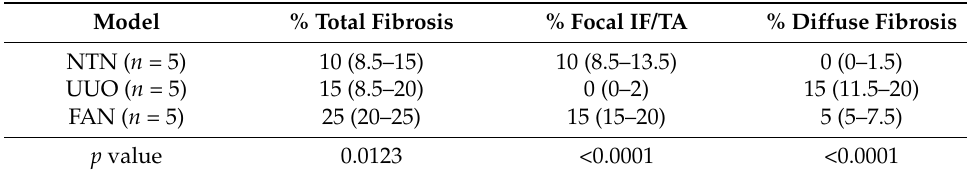
Table 1. Distribution of total fibrosis, focal IF/TA, and diffuse renal fibrosis in experimental kidney diseases with different types of